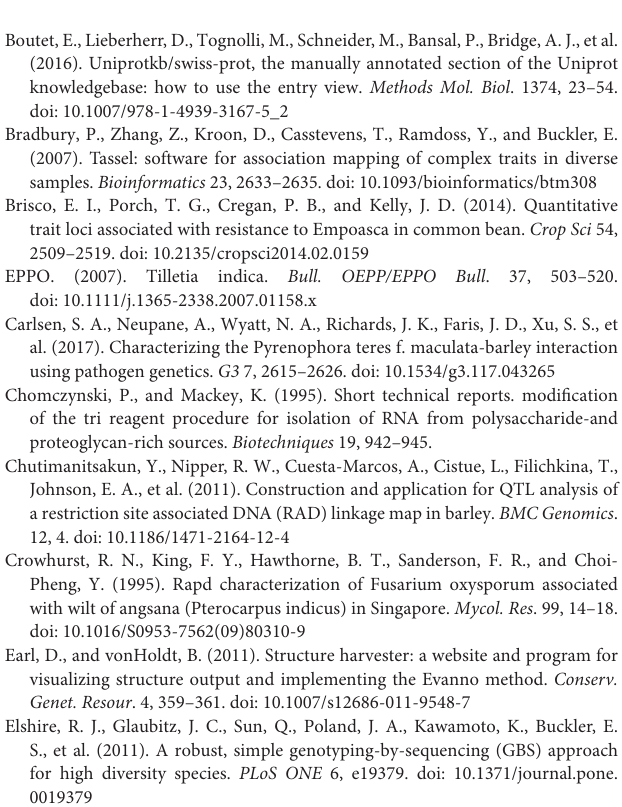
Supplementary Table S3 | Genes and